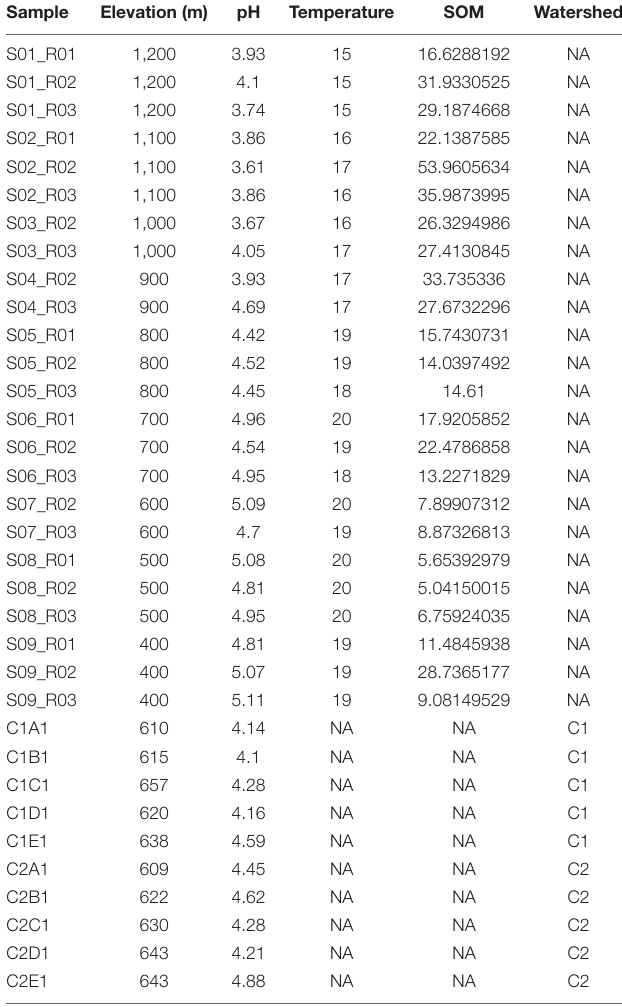
TABLE 1 | Spatial and environmental metadata for each sample at Whiteface Mountain and Woods Lake. Sample